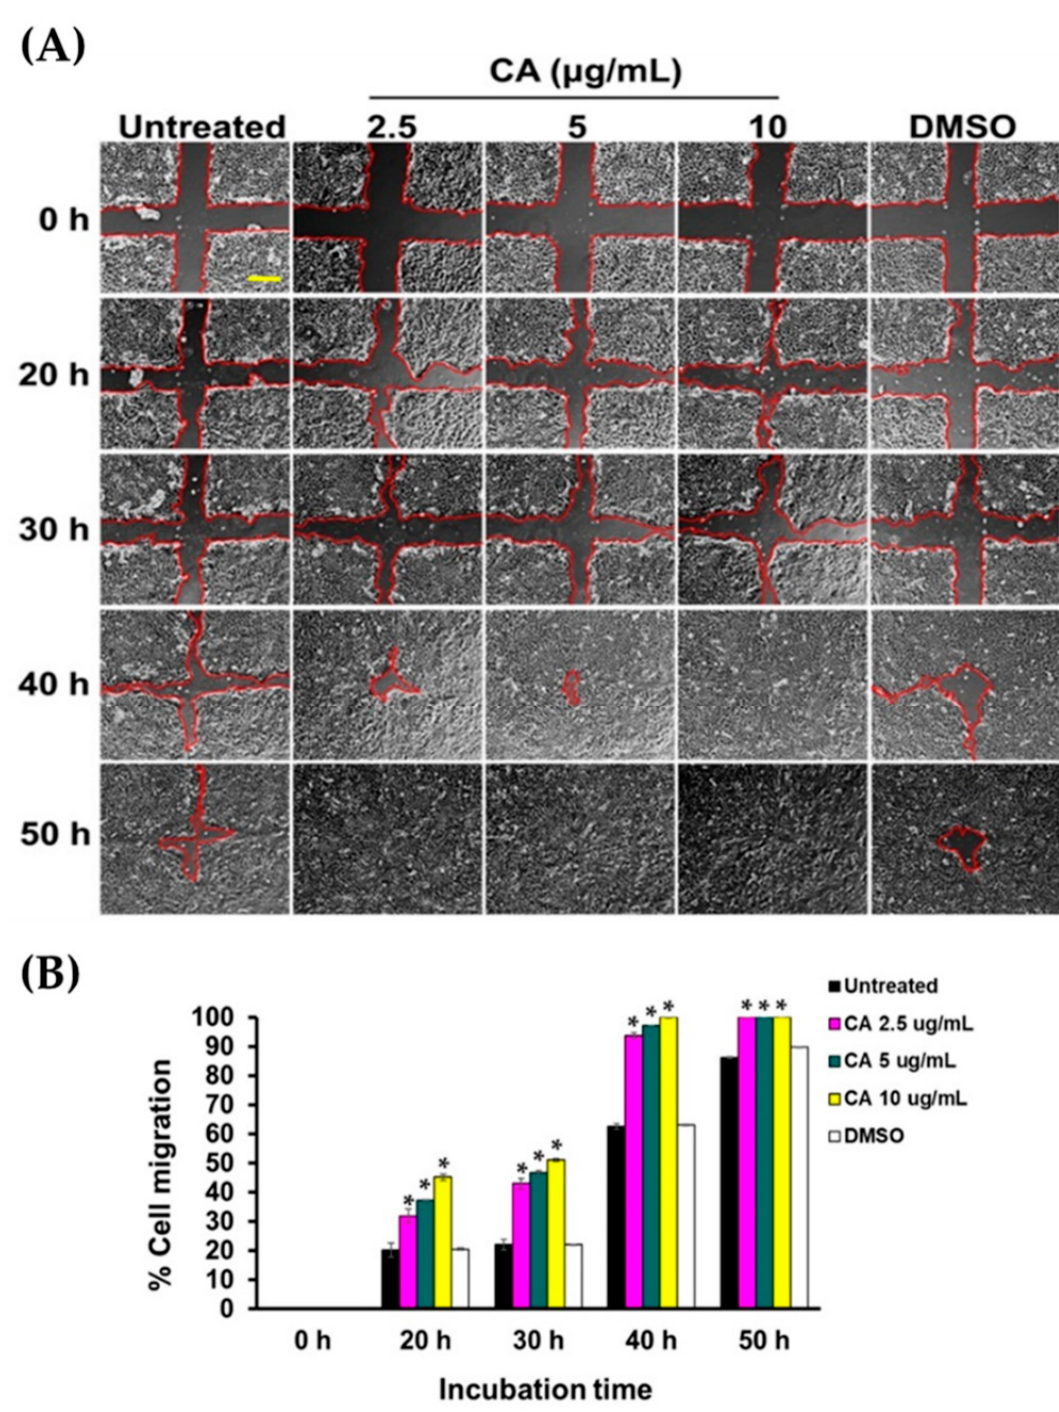
Figure 5. CA extract stimulated HaCaT cell monolayer healing. ( A ) HaCaT cell monolayer treated with CA extract at various concentrations in FBS-free media was monitored for the ability to heal over the course of 50 h by a phase-contrast microscope (10 × magnification, scale bar = 200 µ m). The vehicle control group was treated with DMSO. ( B ) The analysis of percent migration of CA extract-treated HaCaT cells in FBS-free media at each time point (0, 20, 30, 40, or 50 h). Regions confined by the red lines indicate the space with no cell occupation. Data present mean ± SD (* p < 0.05, compared to the untreated).